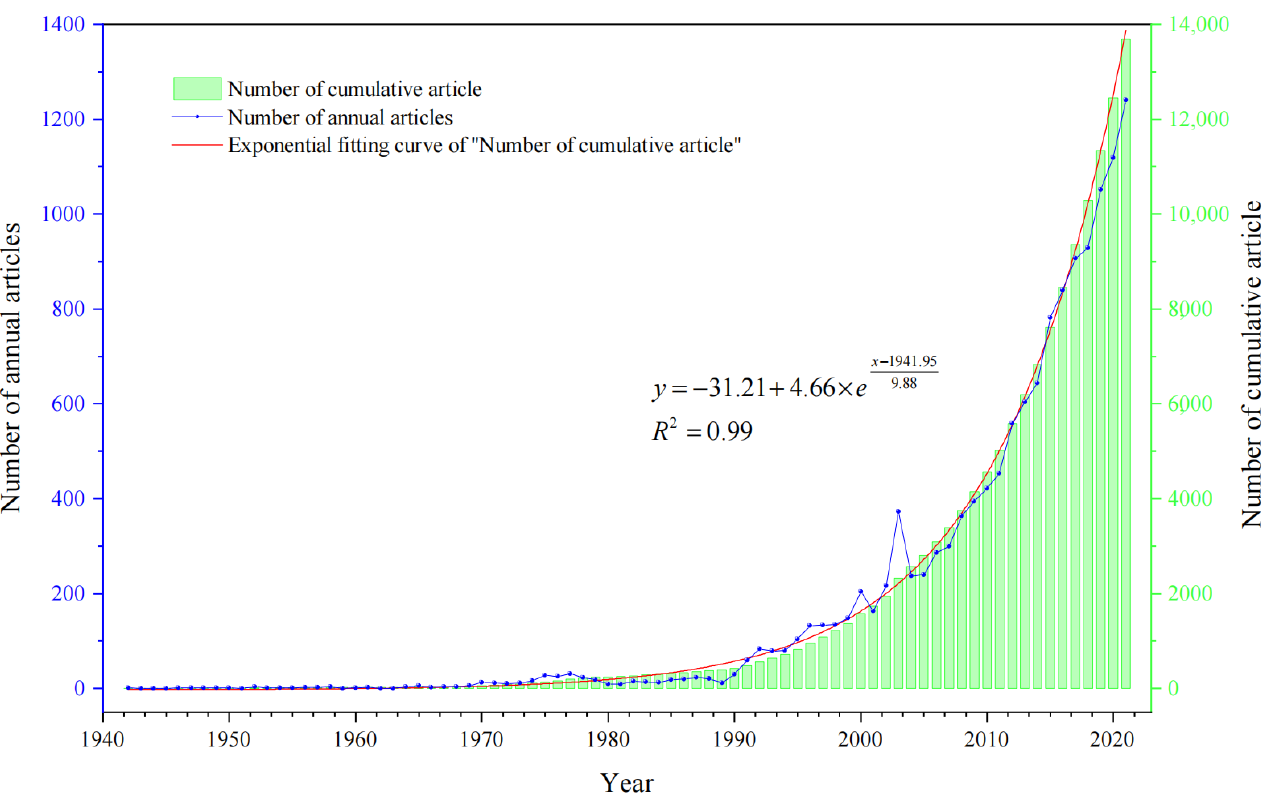
Figure 2. Number of articles issued per year (blue curve with dot) and cumulative number of articles issued (green histogram) from 1942 to 2021. Red curve presents the exponential fitting based on cumulative publications.